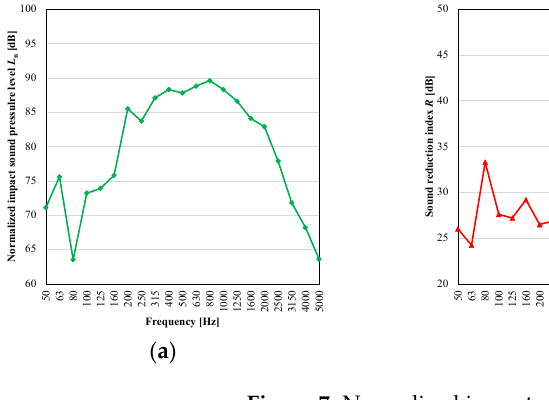
Figure 8. Normalized impact sound pressure level for CLT floor (200 mm) and for concrete floor (140 mm). Due to this important aspect, it is not possible, for example, to use the attenuation data of the impact sound pressure level, obtained on a normalized concrete floor, on wooden floors. The ∆𝐿 (cid:2924) at high frequency, obtained on the normalized concrete floor of a lining, is greater than the same lining applied on a wooden floor, because floating floors are effective above high frequencies, where the wooden floor has a good impact acoustic behavior, with respect to mass. When looking at the sound reduction index, R , (Figure 7b) a resonant frequency at 63 Hz is also determined. It can be noted that a mass ‐ law ‐ like trend, starting from 315 Hz, is present. From the comparison of the impact sound pressure level produced by the standard tapping machine (Figure 7c), and the sound reduction index (Figure 7b), it is clear that the peak of R, at 80 Hz, corresponds to the minimum impact sound pressure level, as expected [67,68]. Then, in the case of the impact sound pressure level and the rubber ball trends, the resonance frequency is also at 63 Hz.